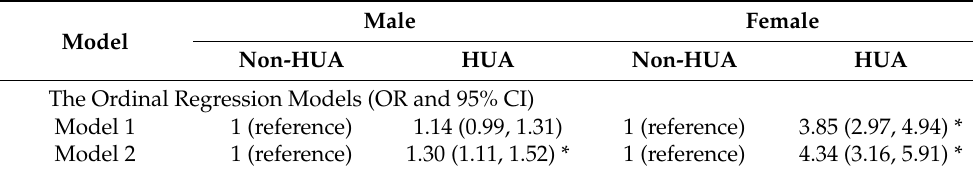
Table 3. Association of hyperuricemia with 10-Year ASCVD risk levels by sex. Male Female Model Non-HUA HUA Non-HUA HUA The Ordinal Regression Models (OR and 95% CI) Model 1 1 (reference) Model